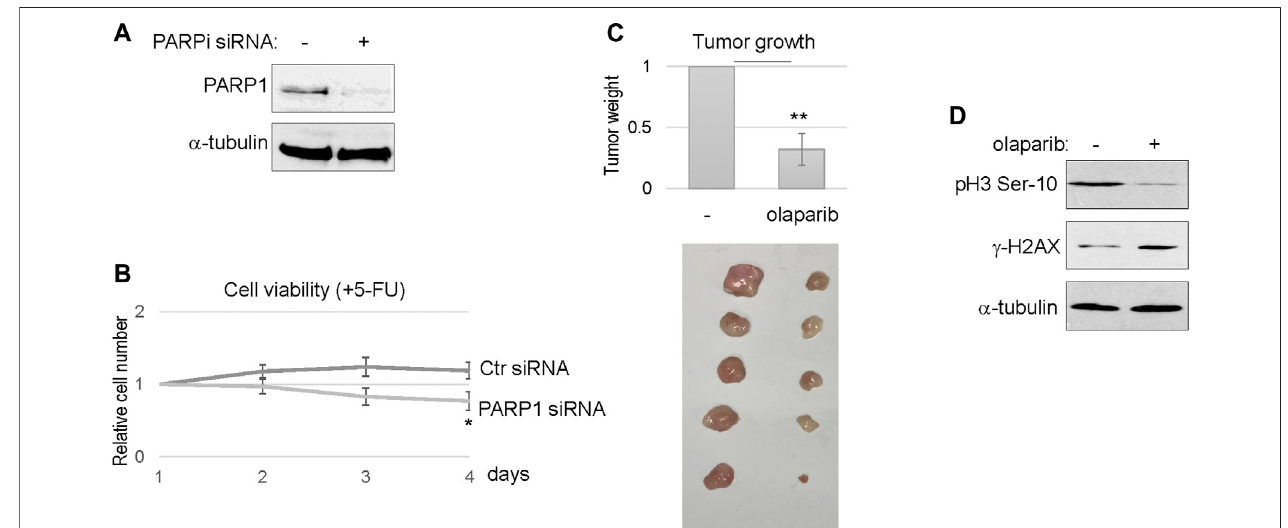
FIGURE 6 | PARP targeting sensitized the SCC11B tumor response to chemotherapy. (A) SCC11B cells were treated with PARP1 siRNA or control siRNA, as described in Materials and Methods. Cells were analyzed by immunoblotting to con fi rm PARP1 depletion. (B) SCC11B cells were incubated for 4 days, with control or PARP1siRNA,asindicated.5-FU(10 μ M)wasaddedatday1.Thecellnumbersatdays2 – 4werenormalizedtothatatday1(untreated).Themeanvaluesandstandard derivations, from three independent experiments, were shown. (C) SCC11B cells were implanted into immunode fi cient mice to form tumors. As described in Materials and Methods, mice were then treated with cisplatin/5-FU, with or without olaparib. Tumors were excised, and shown in the lower panel. The average tumor weight of olaparib/cisplatin/5-FU-treated group was normalized to that of cisplatin/5-FU. The mean values and standard derivations were shown, statistical signi fi cance was determined by Student ’ s t-test ( n (cid:1) 5 per group). (D) Tumor samples were processed, as described in Materials and Methods, and analyzed by